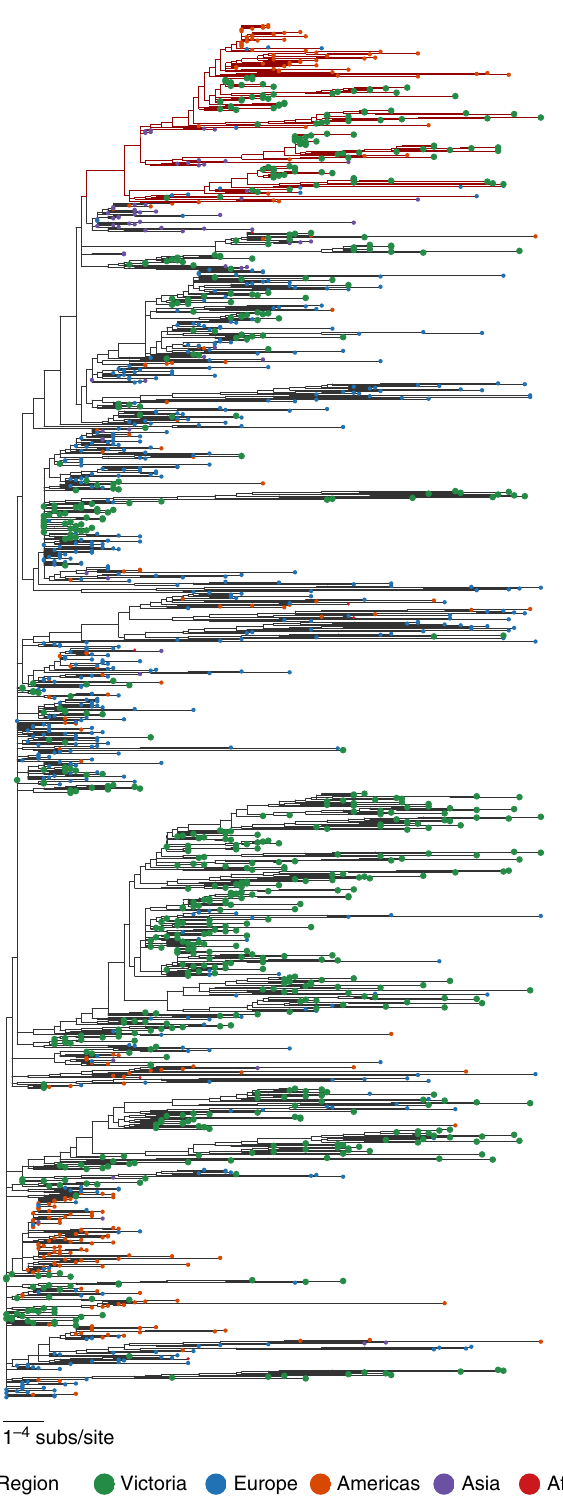
Fig. 3 Phylogenetic tree of Victorian severe acute respiratory syndrome coronavirus 2 (SARS-CoV-2) sequences with international context. Maximum likelihood tree of Victorian SARS-CoV-2 sequences and a subset random selection of international sequences representing global genomic diversity, colored by region of origin. Victorian isolates, in green, have been emphasized through increased size, and represent the global diversity of the sampled SARS-CoV-2 population. Branch color represents Pangolin lineage A (red) or B